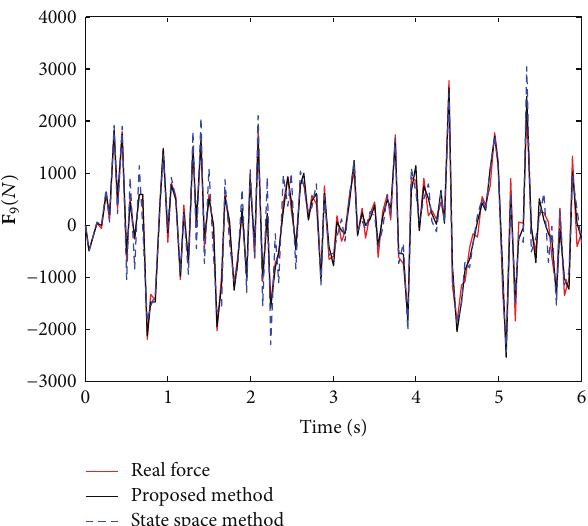
Figure 11: Force identification results of F 9 .